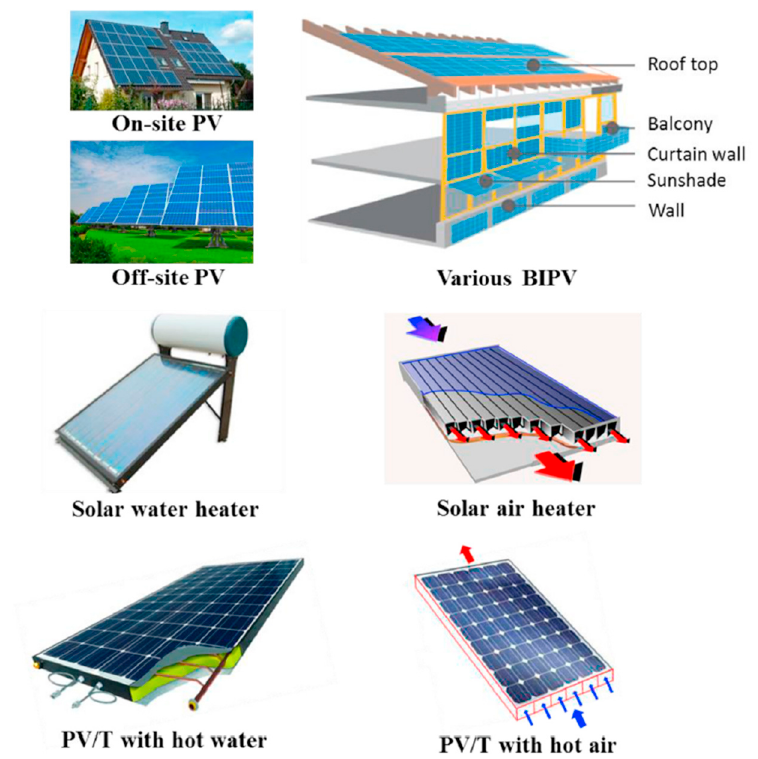
Figure 7. Solar energy conversion technologies for buildings, [28].